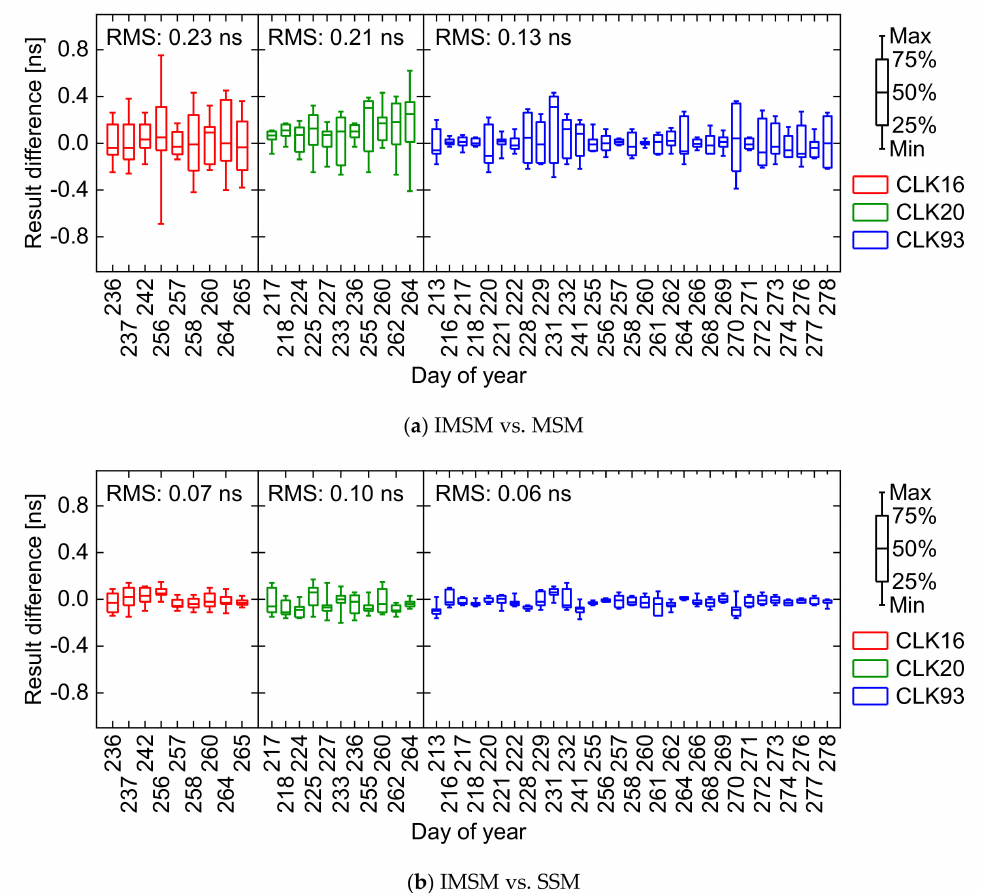
Figure 7. Result di ff erences of the improved multi-satellite method (IMSM) with respect to the multi-satellite method (MSM) ( a ) and the single-satellite method (SSM) ( b ). The boxplot provides the statistical values of the result di ff erences, including minimum / maximum values, lower / upper quartiles, and